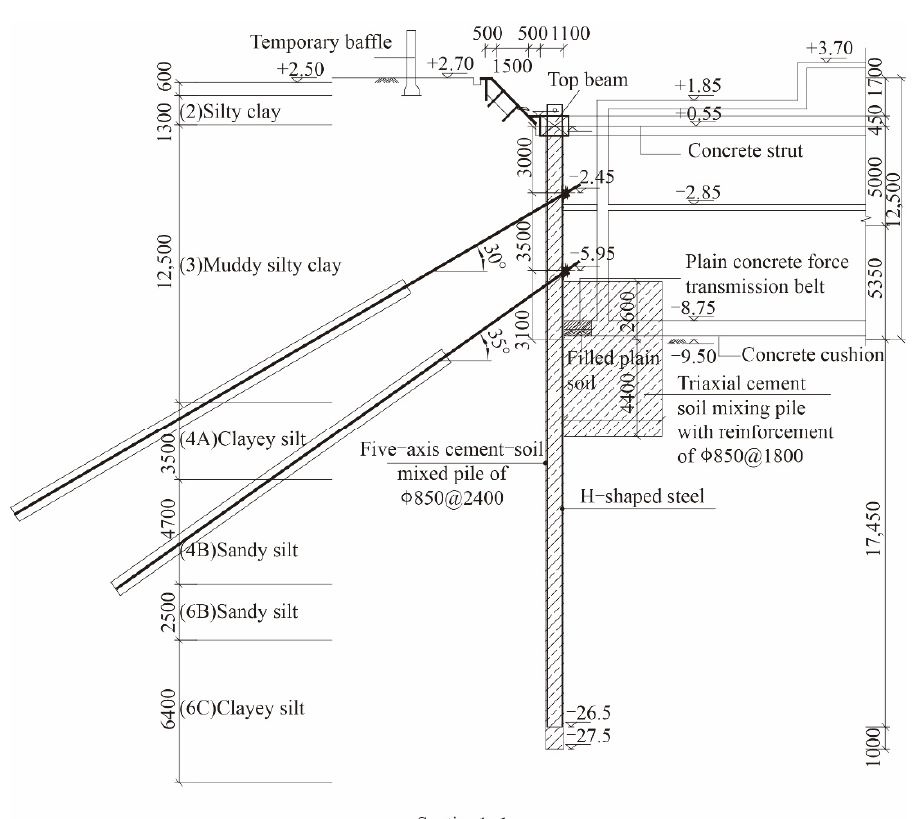
Figure 2. Typical support section (unit: mm).